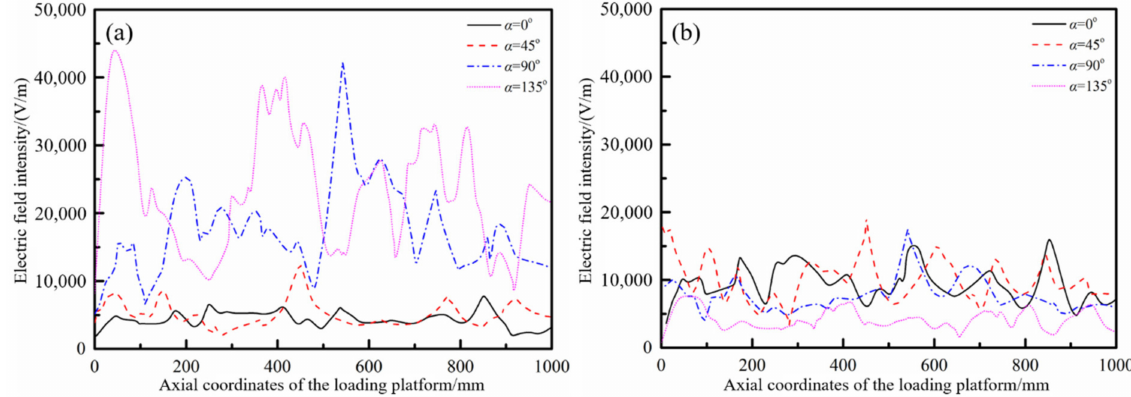
Figure 11. Variations of the electric field intensity along the axis under two types of working conditions: ( a ) number (6); ( b ) number